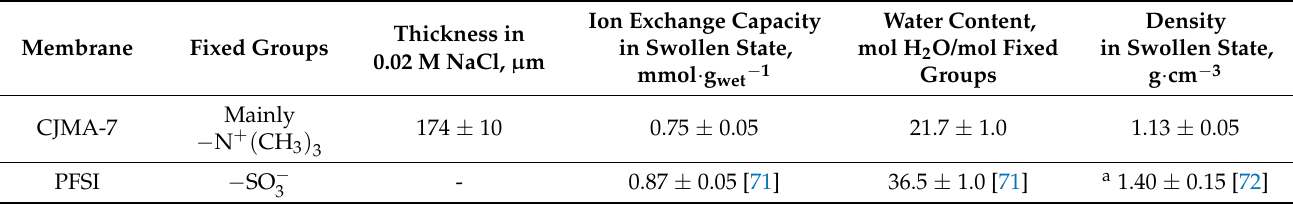
Table 2. Some characteristics of studied